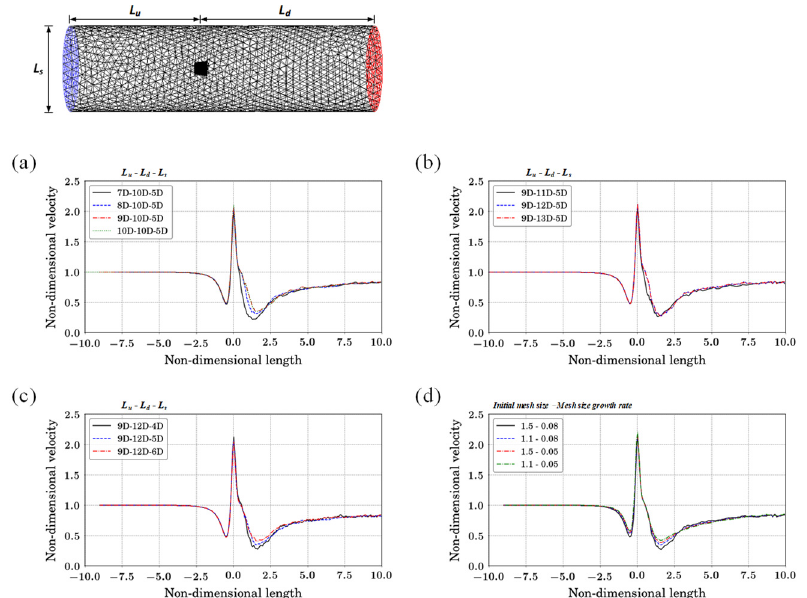
Figure 5. Comparisons of simulated inline velocity of different domain lengths and mesh numbers: ( a ) upstream length ( L u ), ( b ) downstream length ( L d ), ( c ) side length ( L s ), and ( d ) mesh size and growth rate. The computational domains for translational motions, D the nozzle inlet diameter.